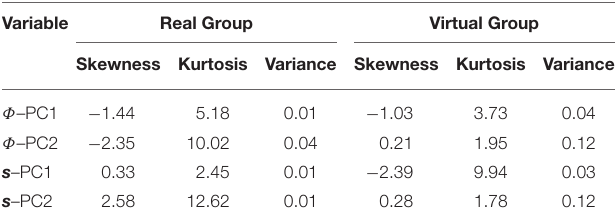
TABLE 1 | Descriptive properties of the Φ and s PC coefficient distributions for PC1 and